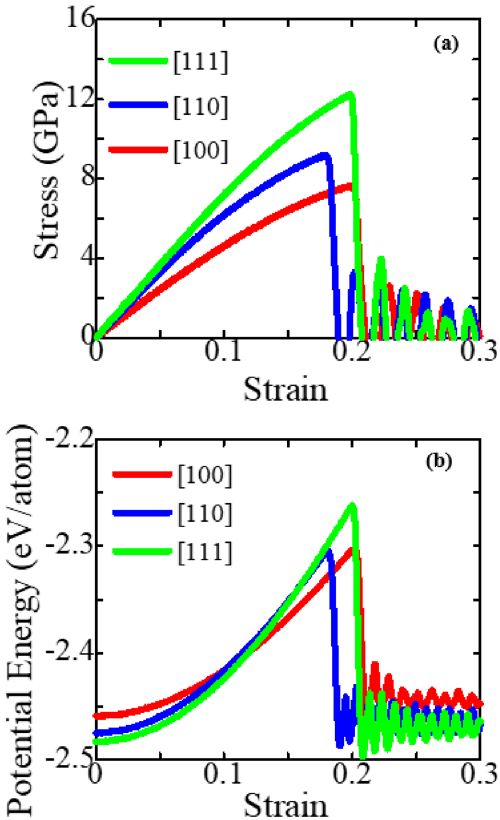
Figure 2. ( a ) Stress–strain response and ( b ) potential energy/atom of 15.76 nm 2 zinc-blende ZnSe NWs for different crystal orientations at 300